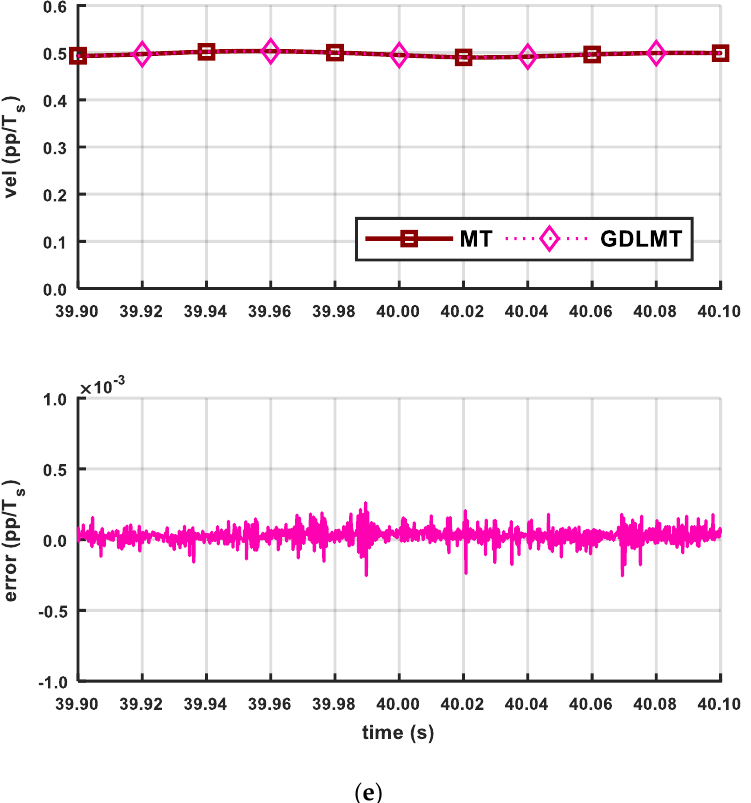
Figure 12. Comparison of the MT method and the GDLMT method at low speed: ( a ) full time interval; ( b ) detail 1 with velocity overshoot (peak velocity); ( c ) detail 2 with velocity zero crossing; ( d ) detail 3 with ramp velocity (constant acceleration), and ( e ) detail 4 with constant velocity.